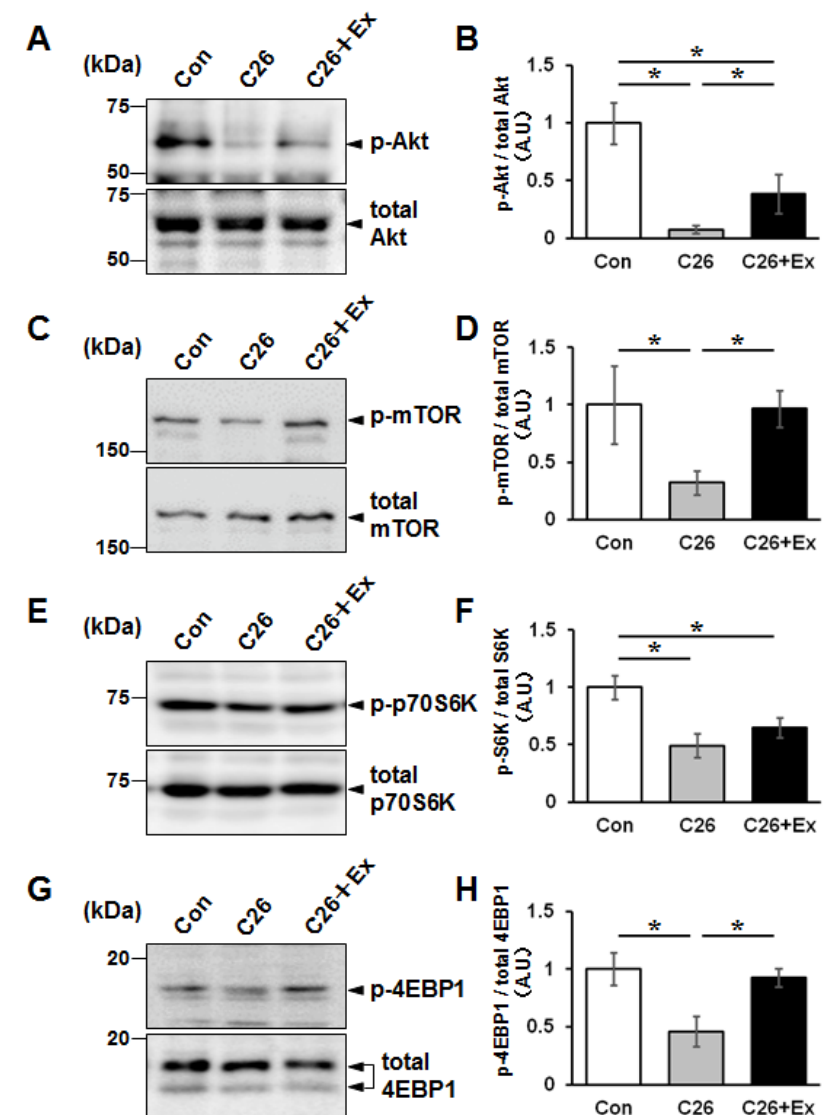
Figure 3. Aerobic exercise enhances the stimulation of Akt signaling cascade. Western blot analysis was performed on the TA of the mice in Figure 2 using anti-phospho-Akt (p-Akt) and pan-Akt (total Akt) antibodies ( A ), anti-phospho- and pan-mTOR ( C ), anti-phospho- and pan-p70S6 kinase ( E ), and anti-phospho and pan-4EBP-1 antibodies ( G ). The data represents the results of three independent experiments. Densitometric analyses of Western blot shown in ( A , C , E , G ) are presented in ( B , D , F , H ), respectively. The bar graphs indicate the mean relative expression ± SD. Statistical analysis was performed by Kruskal-Wallis analysis followed by Mann-Whitney U tests. *: p < 0.05.